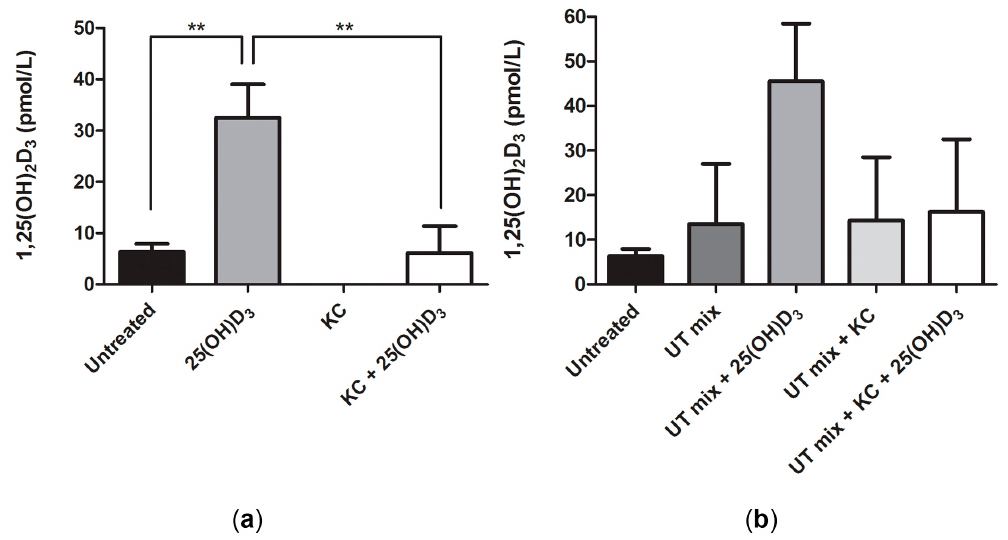
Figure 2. Conversion of vitamin D precursor to biologically active 1,25(OH) 2 D 3 by ciPTEC-OAT1. ( a ) Release of 1,25(OH) 2 D 3 in cell culture supernatant after 24 h incubation with inactive 25(OH)D 3 (100 nM), in absence or presence of 1 α -hydroxylase inhibitor, ketoconazole (KC; 10 µ M); ( b ) Release of 1,25(OH) 2 D 3 after 24 h incubation with 25(OH)D 3 (100 nM), in absence or presence of ketoconazole (10 µ M) and 1 × UT mix. Concentration expressed as pmol/L (mean ± SEM). Three independent experiments were performed. ** p < 0.01 (One-way ANOVA followed by Dunnett’s multiple comparison test, using as a control either untreated sample or 25(OH)D 3 treated sample, as indicated).